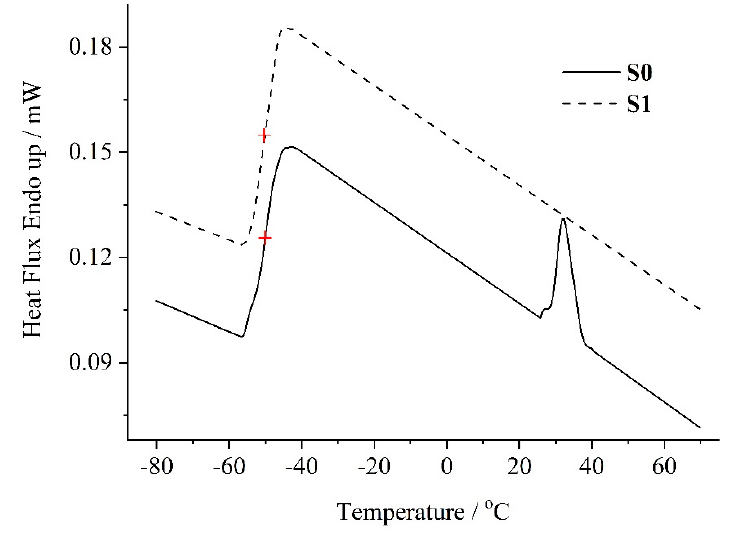
ff erential scanning calorimetry (DSC) curves of P(BAMO-r-THF) Figure 1. Differential scanning calorimetry (DSC) curves of P(BAMO-r-THF) elastomers. Figure 1. Di